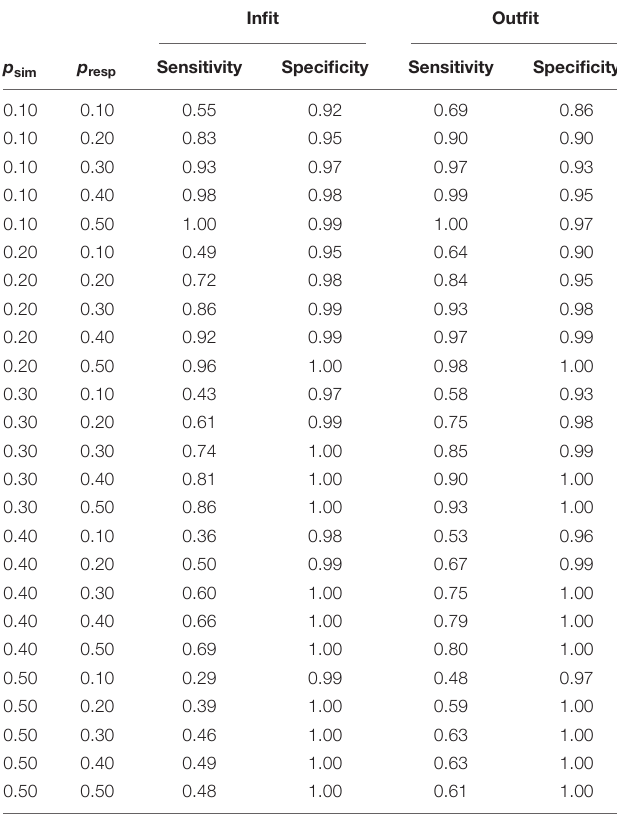
TABLE 2 | Sensitivity and specificity of infit and outfit in the tests with polytomous items. Infit